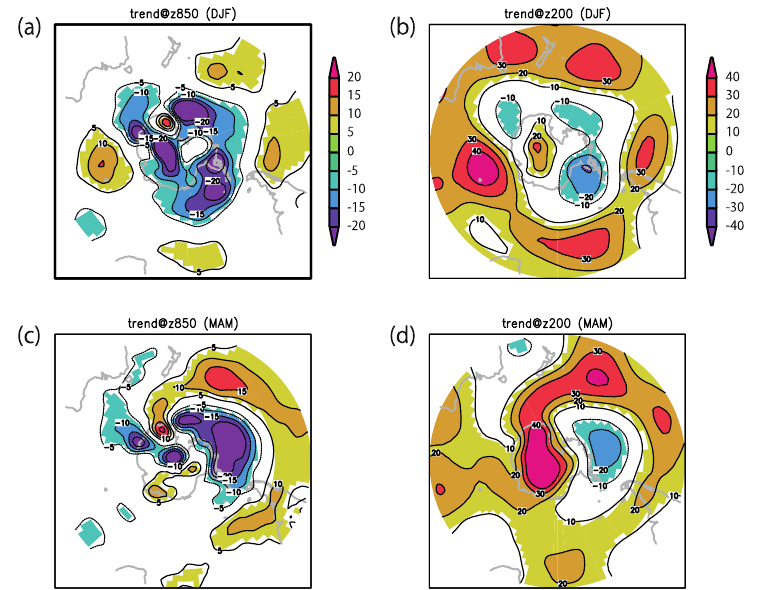
Figure 13. Difference in seasonal means between 1983 – 2001 and 2002 – 2020. ( a ) z850, and ( b ) z200 in DJF. ( c , d ) are same as ( a , b ) but during MAM.